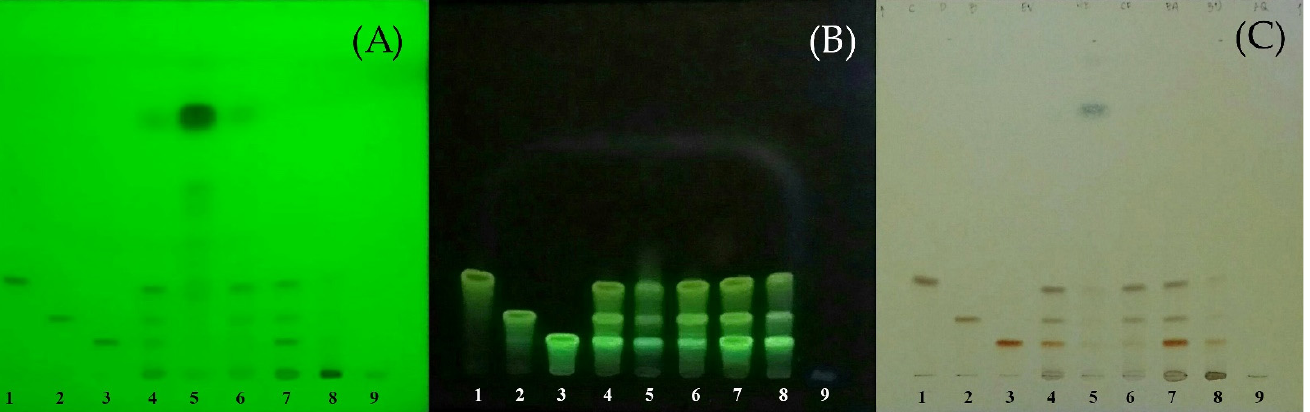
Figure 1. TLC chromatograms of standard curcuminoids and all turmeric rhizome fractions. Track 1 = standard curcumin (CM); 2 = standard desmethoxycurcumin (DCM); 3 = standard bisdesmethoxycurcumin; 4 = EV; 5 = HE; 6 = CF; 7 = EA; 8 = BU; 9 = AQ. Solvent system, benzene/chloroform/ethanol (49:49:2 by volume). Detection: ( A ) = UV 254 nm; ( B ) = UV 366 nm; ( C ) = 10% phosphomolybdic spray reagent; all heated at 105 °C for 5 min, detected under white light.